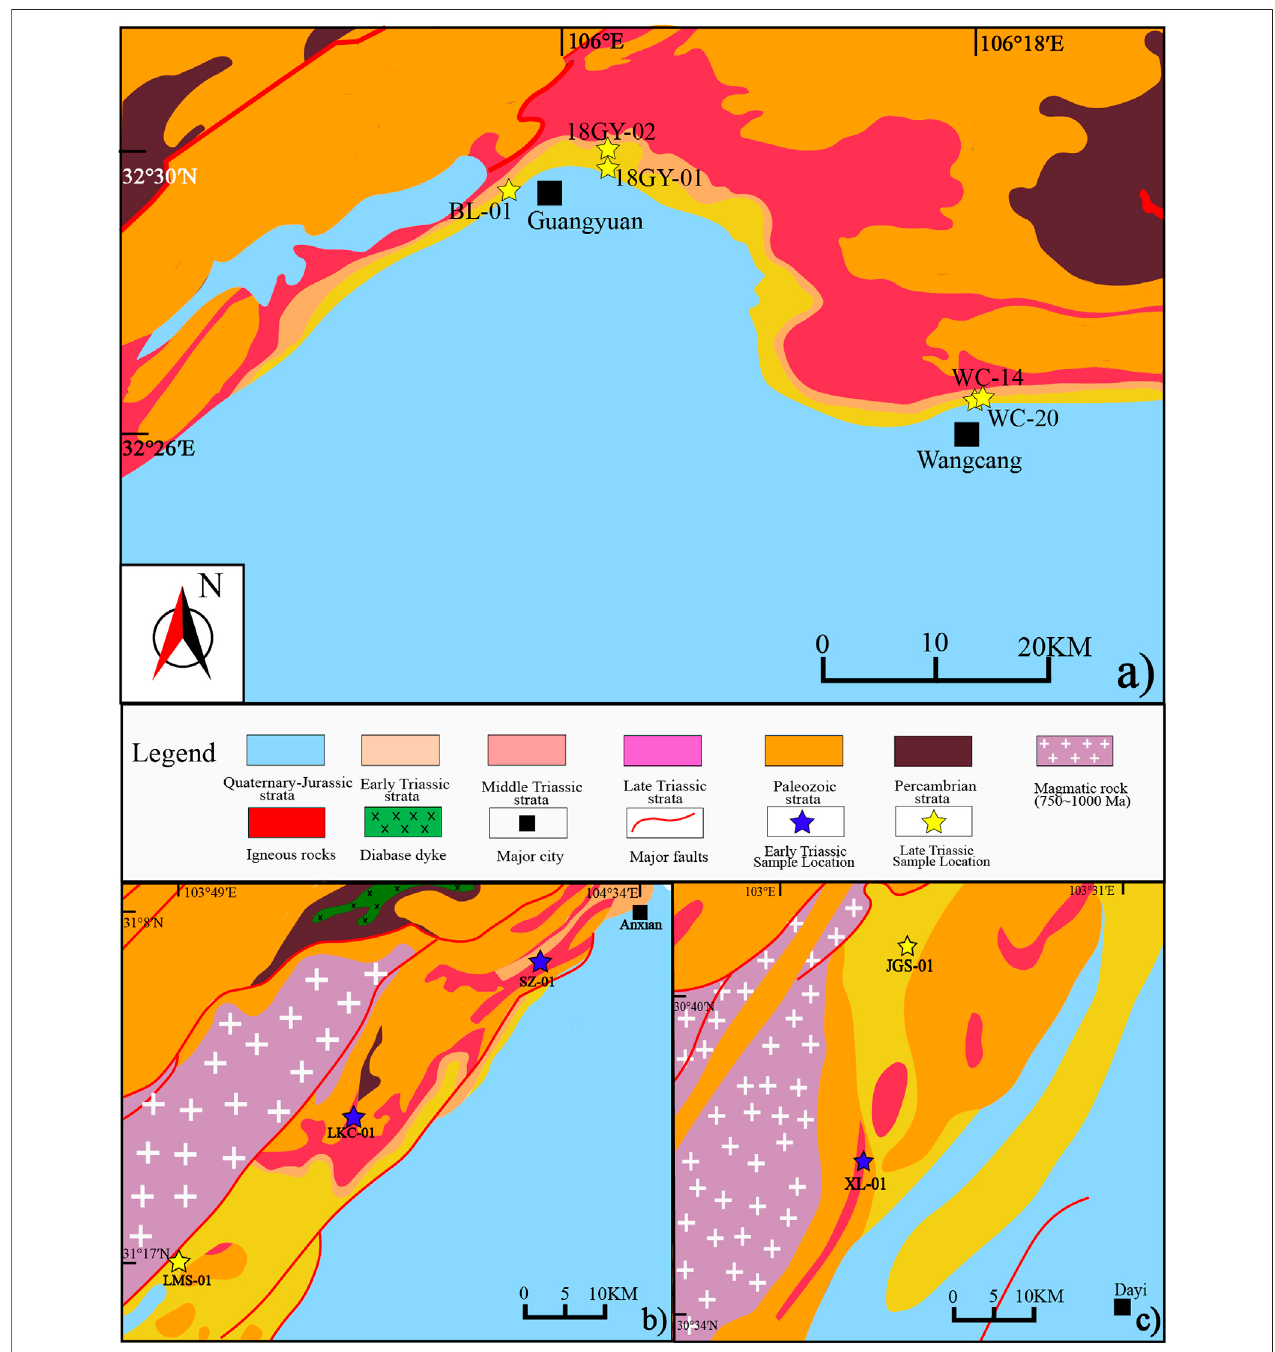
FIGURE 4 | Speci fi cgeologic sketch map and sample locations ofour study: Guangyuan (A) , Qionglai (B) , and Mianyang (C) (modi fi ed after the geological map of Sichuan Province).